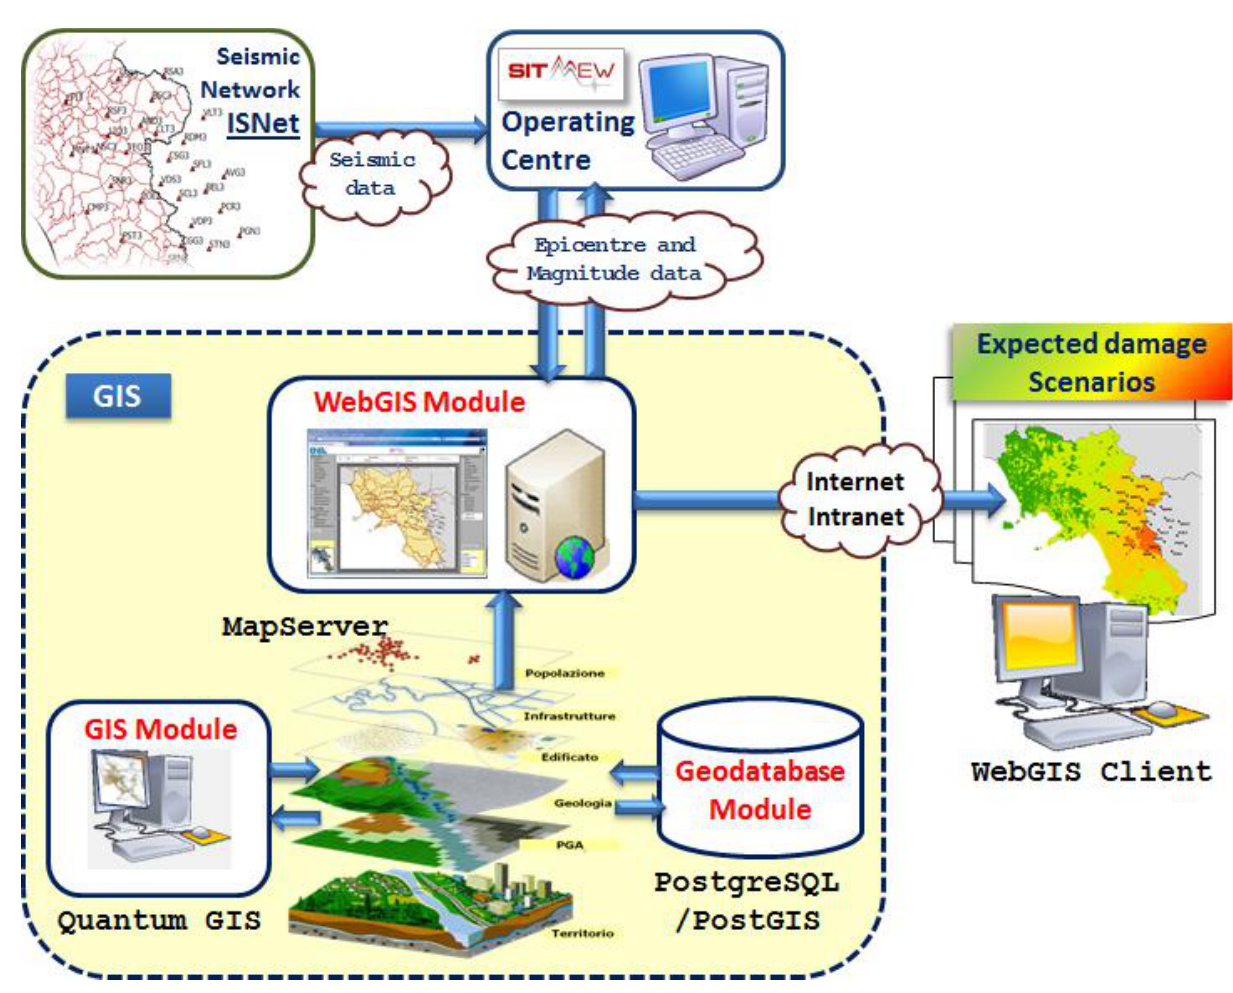
Figure 5. Geographical Information System (GIS) logical architecture: GIS modules are represented inside the dashed box, to differentiate them from other subsystems developed within the SIT_MEW